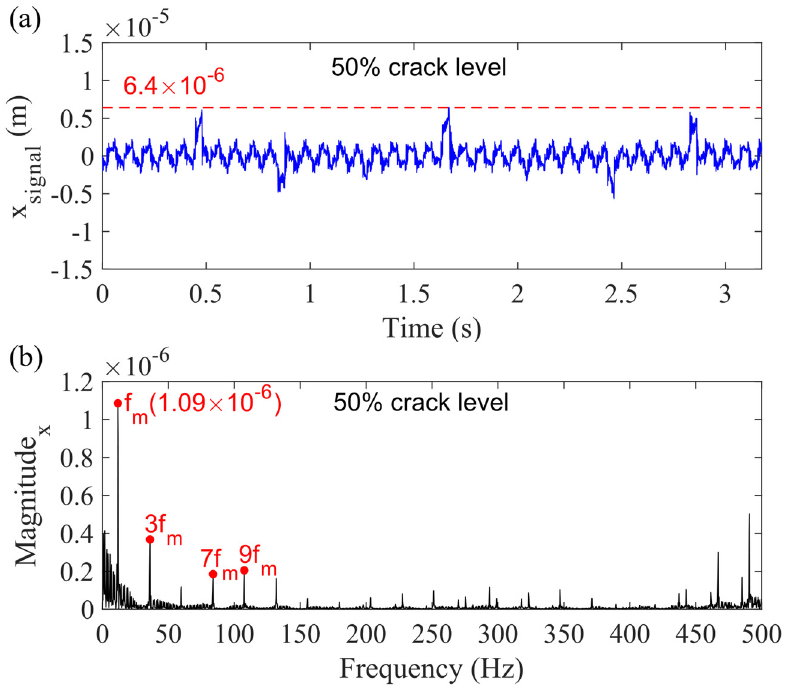
Figure 16. Sum vibration response with 50% sun gear crack level for Case 4 in ( a ) time domain and ( b ) frequency domain in x g -direction.